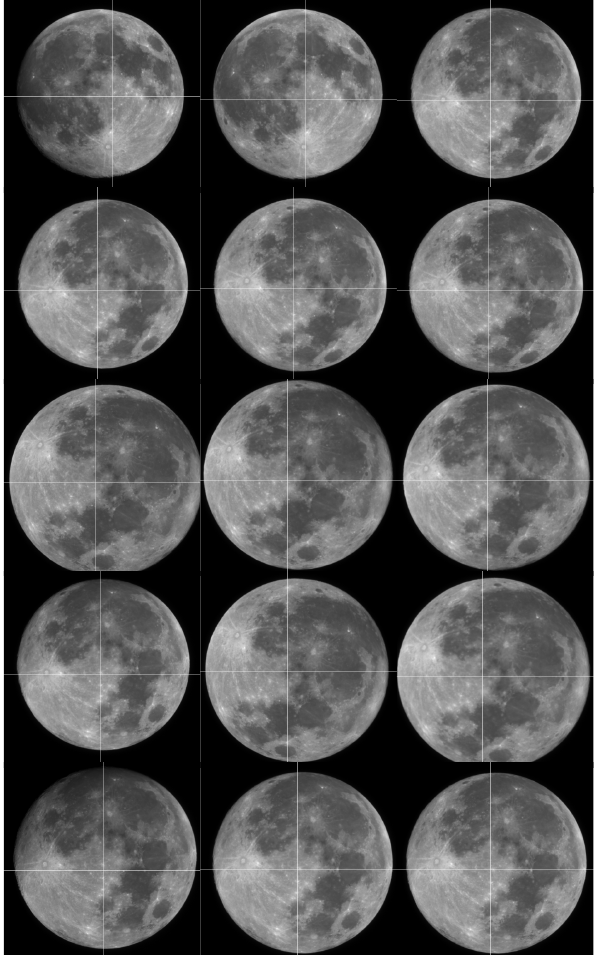
Figure 6. The 15 ROLO reference images. The white lines mark the boundaries of the four quadrants in the SFD simulation after adjustment. The images are listed in Table 1 from top left to bottom